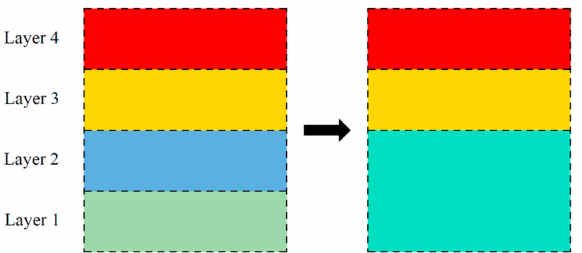
Figure 7. Graphical representation of the layer mixing